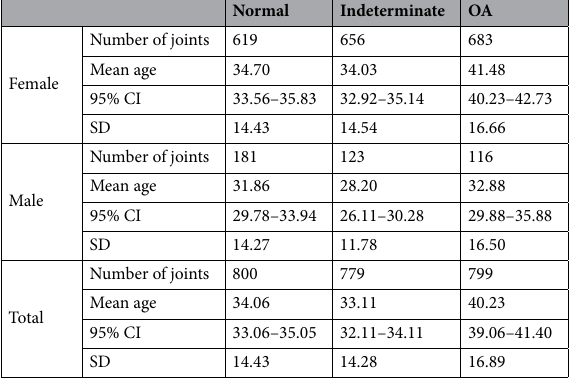
Table 1. Clinical and demographic characteristics of the OPG dataset. Indeterminate, indeterminate temporomandibular joint osteoarthritis; OA, temporomandibular joint osteoarthritis.